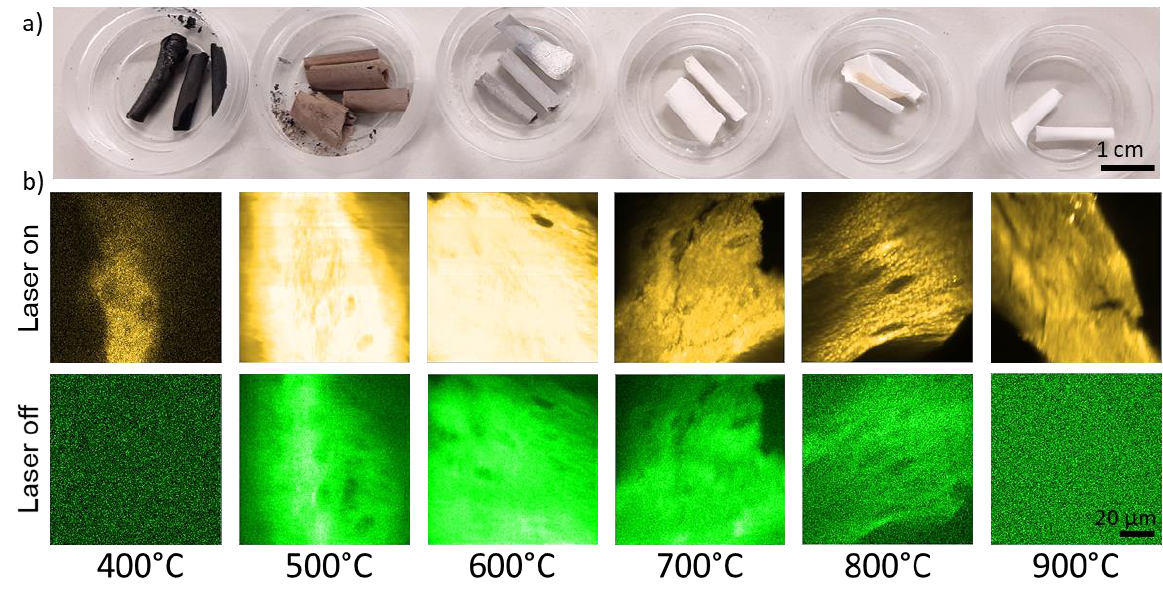
Figure 2. ( a ) Photographs of chicken bone samples after being exposed to maximum temperatures between 400 ◦ C and 900 ◦ C. ( b ) Microscopic photoluminescence images of the different samples. The brightness reflects the intensity of fluorescence (laser on) and phosphorescence (laser off), respectively. Yellow and green pseudo colors were applied to increase the image clarity.